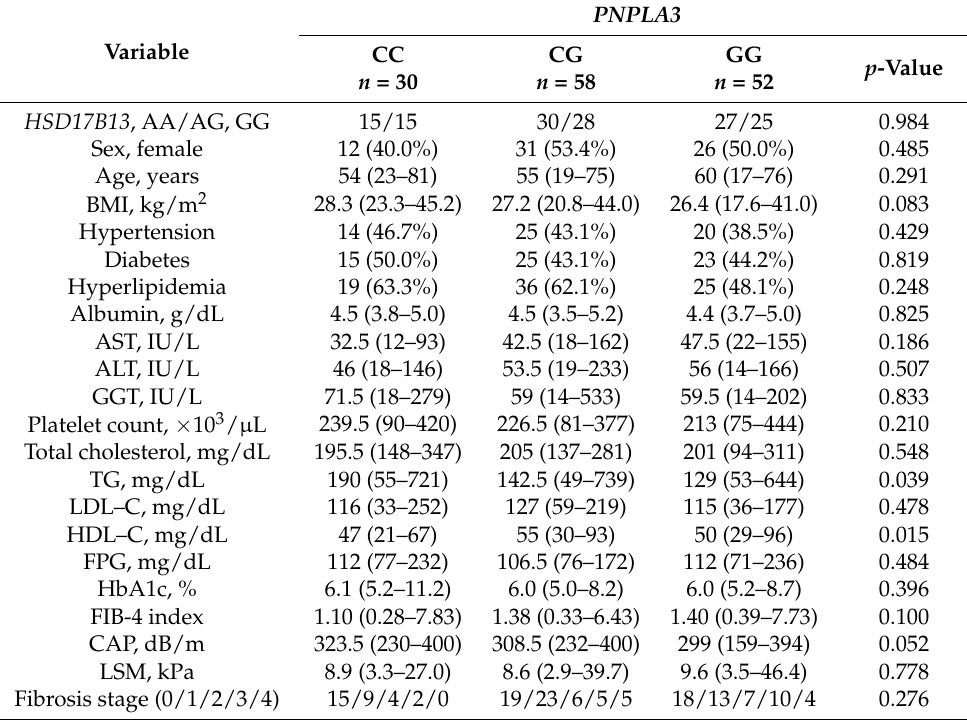
Table 1. Characteristics of the NAFLD patients according to the PNPLA3 genotype.